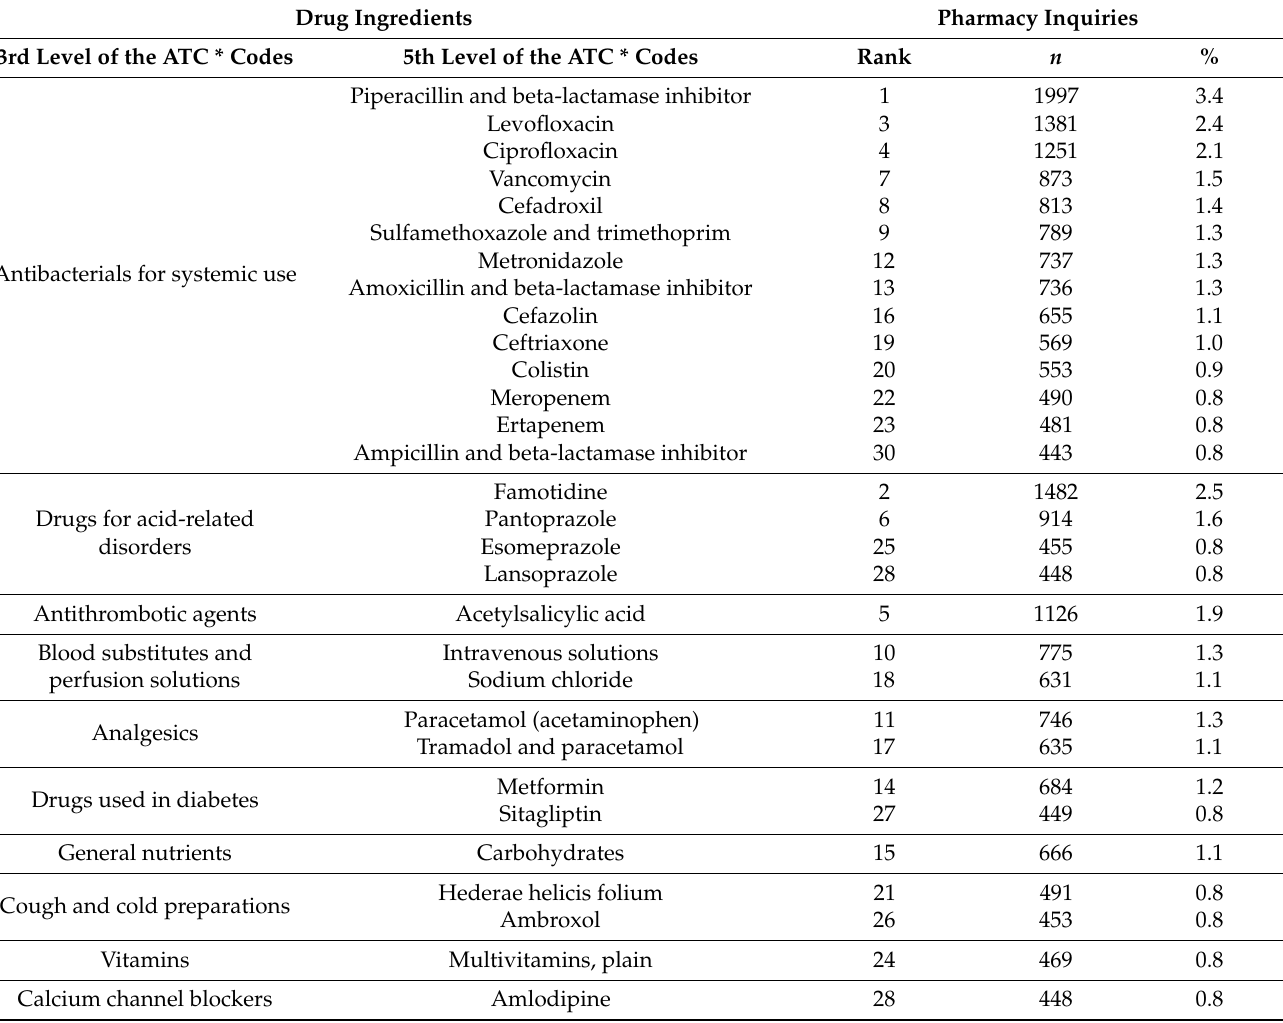
Table 2. Top 30 frequent drug ingredients of pharmacy